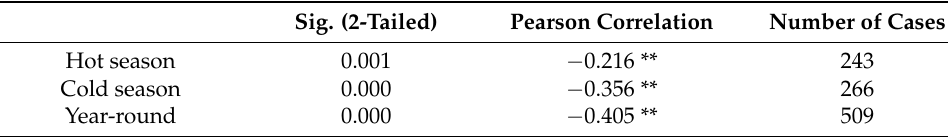
Table 7. Correlation analysis of TPV and